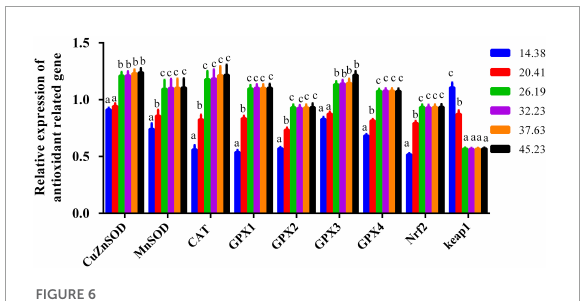
FIGURE6 The muscle mRNA expression of antioxidant-related genes of juvenile softshell turtles a gradient of dietary supplementary protein levels for 8 weeks. Bars with different letters indicate significant differences among the groups ( P < 0.05). The values shown are the mean ± SD for three